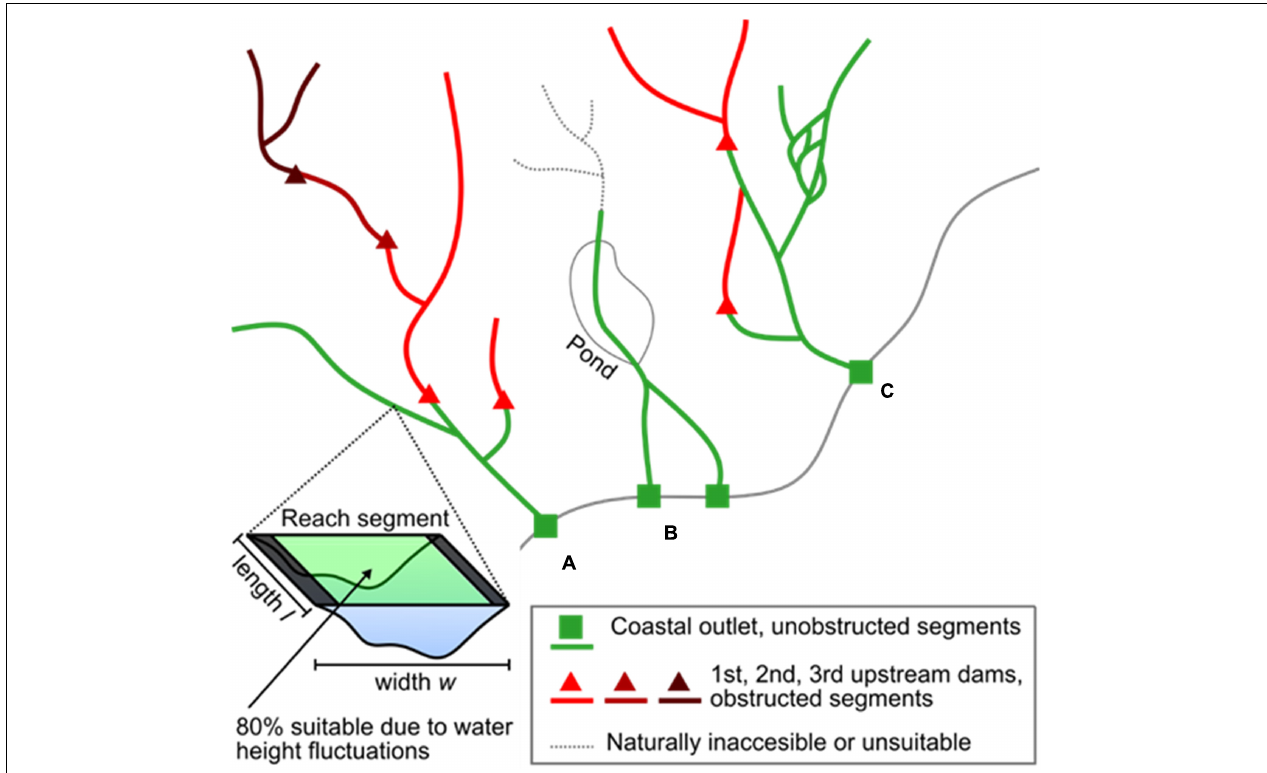
FIGURE 2 | Example of our approach to habitat area calculation. (A) Habitat was calculated for all reach segments. We then summed habitat groups that occurred between point features (e.g., habitat between a coastal outlet point and the first upstream dams in that river, habitat between a dam and other dams immediately upstream). (B) Rivers that bifurcated along the coast were summed as a single habitat group due to their upstream connection. Reach segments deemed inaccessible or unsuitable by experts were excluded from the habitat calculation, in addition to pond and lake areas. (C) We included downstream bifurcations in our habitat group calculations. Dams located on a bifurcation obstructed habitat only to the end of the bifurcation when other dominant flow paths were